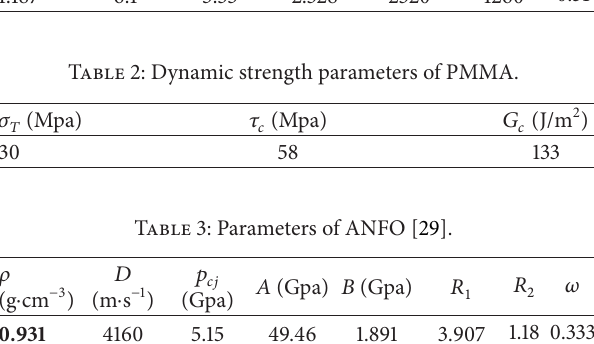
Figure 7: p wave scattering near the